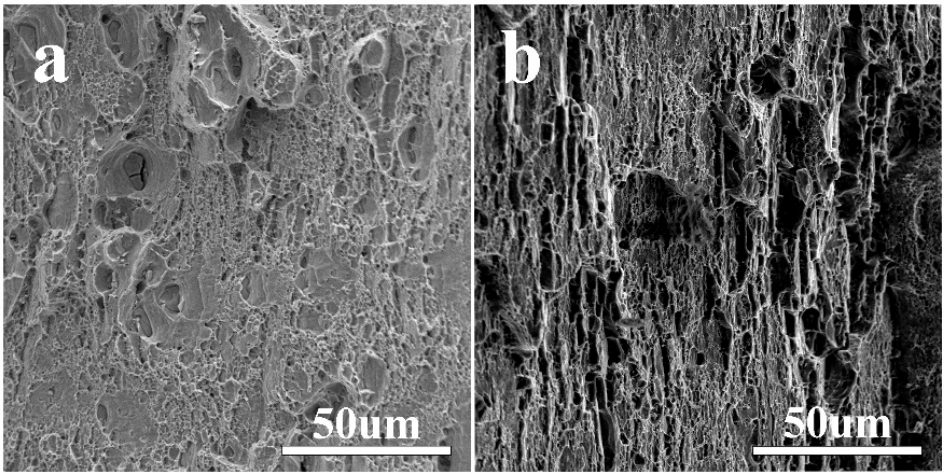
Figure 6. Fractographs of tensile fracture in the T6-treated sample ( a ) and AR sample ( b ).